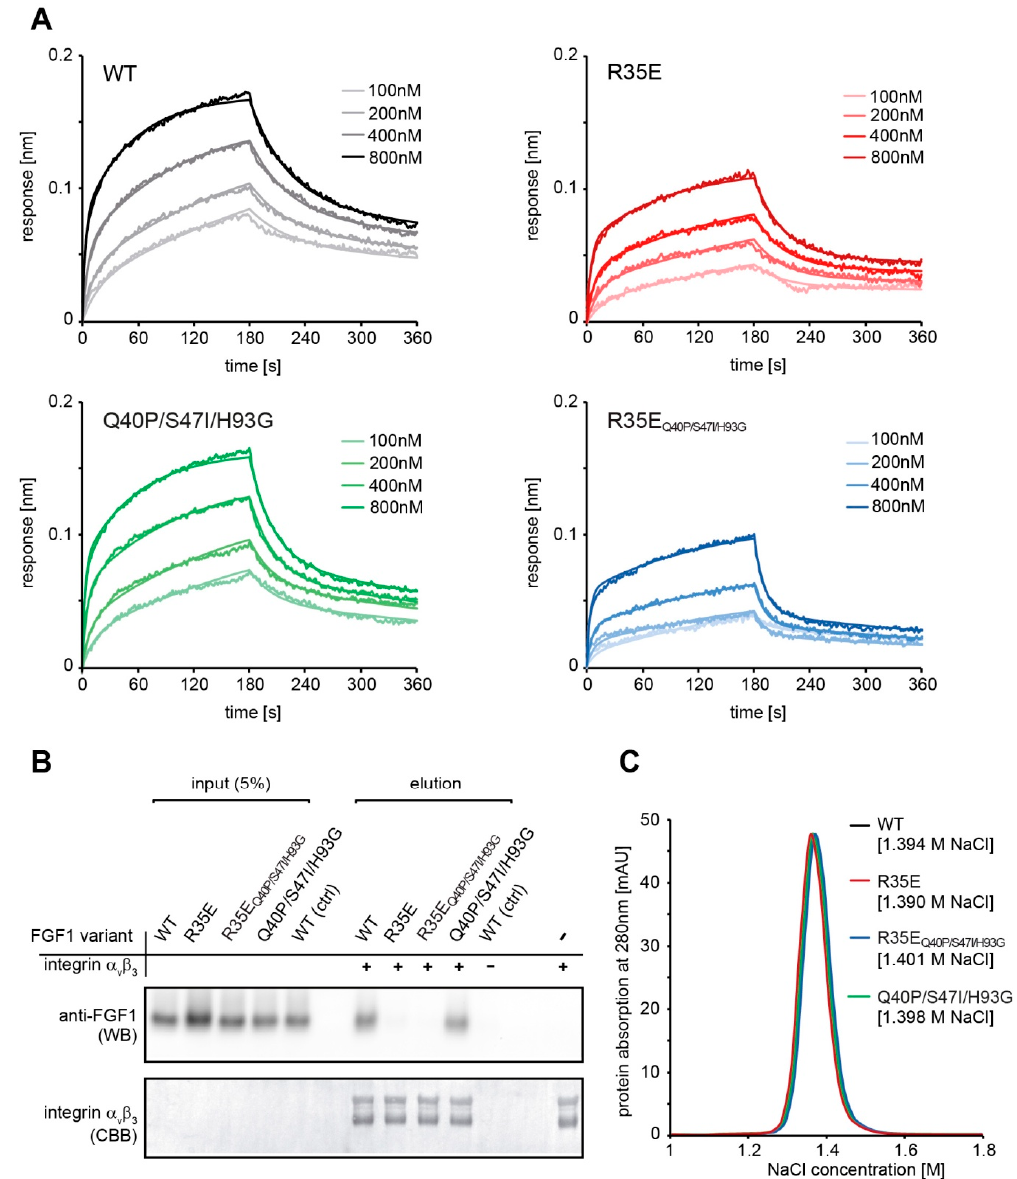
Figure 2. Stabilizing mutations do not interfere with binding properties of FGF1. ( A ) Binding profiles of FGF1 variants to FGFR1 were measured by the bio-layer interferometry (BLI) technique. Serial twofold dilutions of the FGF1 variants were analyzed for interaction with FGFR1-Fc immobilized on sensors coated with Protein A. ( B ) Verification of FGF1 variants interaction with integrin α v β 3 by pull down. Integrin α v β 3 was immobilized on Co 2+ -NTA resin and incubated with FGF1 variants. FGF1 proteins bound to integrin were eluted and detected with western blotting using anti-FGF1 antibody. An equal amount of immobilized integrin α v β 3 was confirmed by CBB staining. ( C ) Elution profiles of FGF1 variants from a Heparin-Sepharose column with a NaCl gradient.